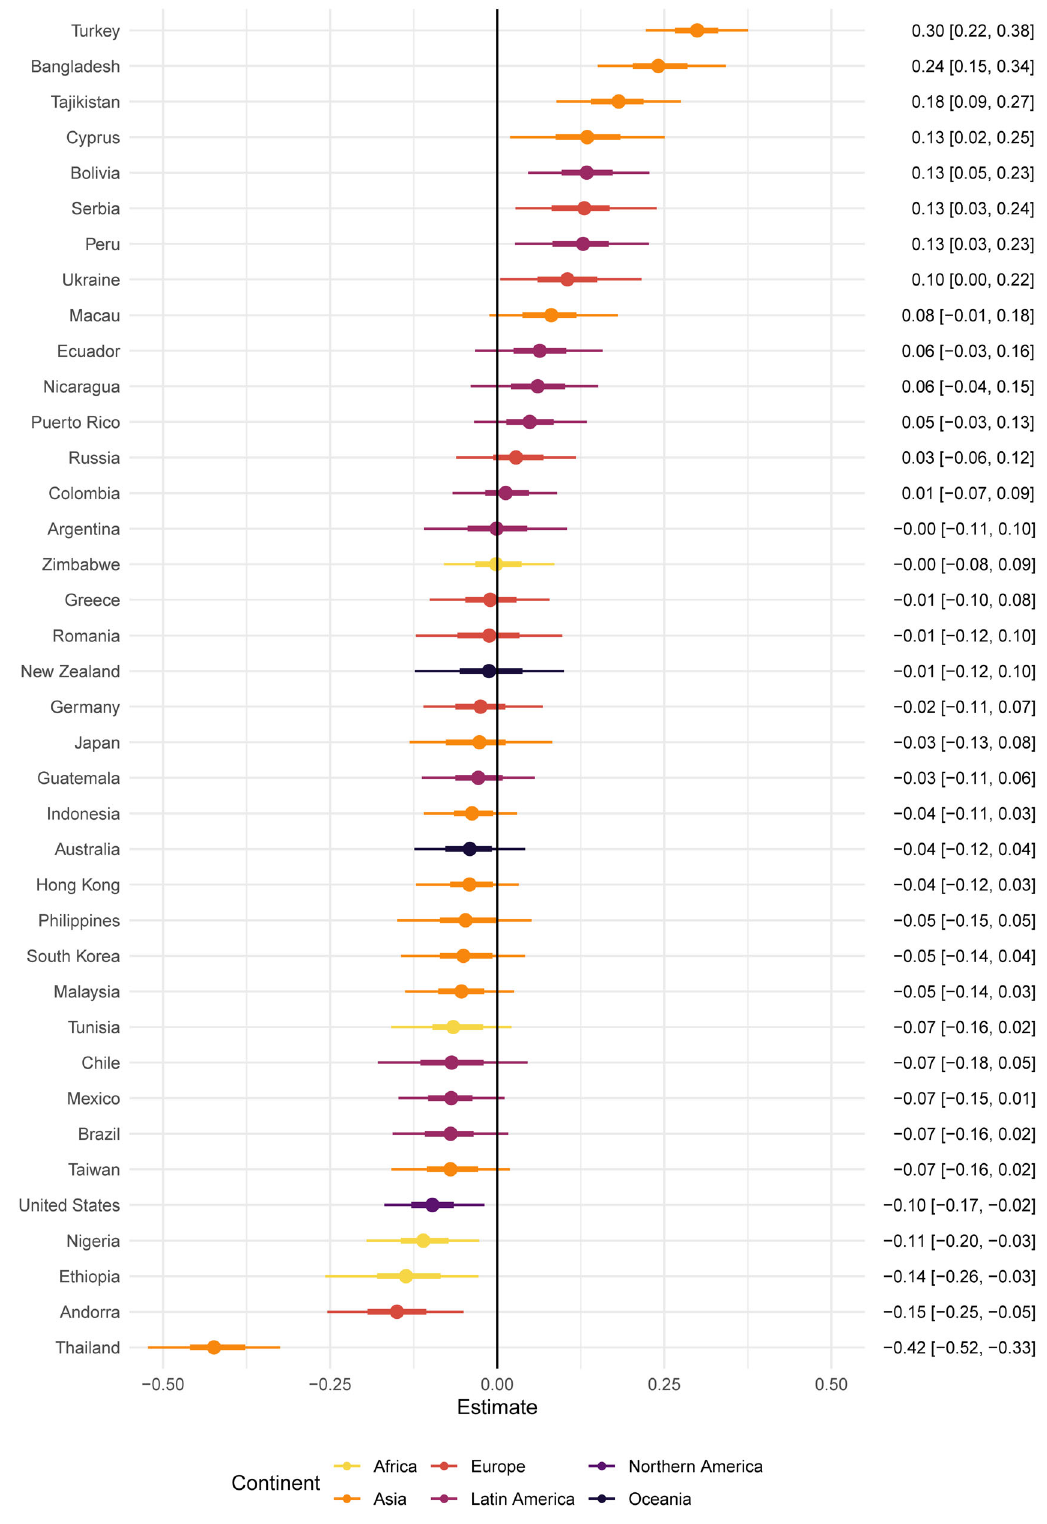
Fig. 2 Country-level effects of legacy media use on anti-science attitudes. Note : Points represent means of posterior probability distributions of varying slopes of media use (estimated with Bayesian multilevel regression, Model 1). Thin horizontal lines represent 89% HDIs. Thick horizontal lines represent 50% HDIs. Values indicate distribution means as well as lower and upper bounds of 89%